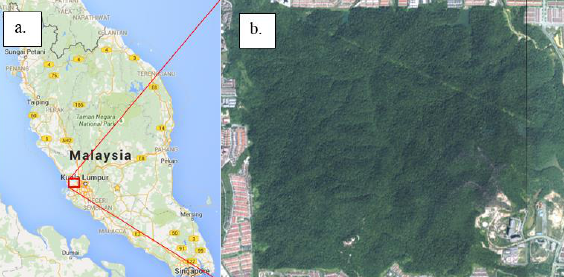
Figure 2. A map of the location of the study area. Figure